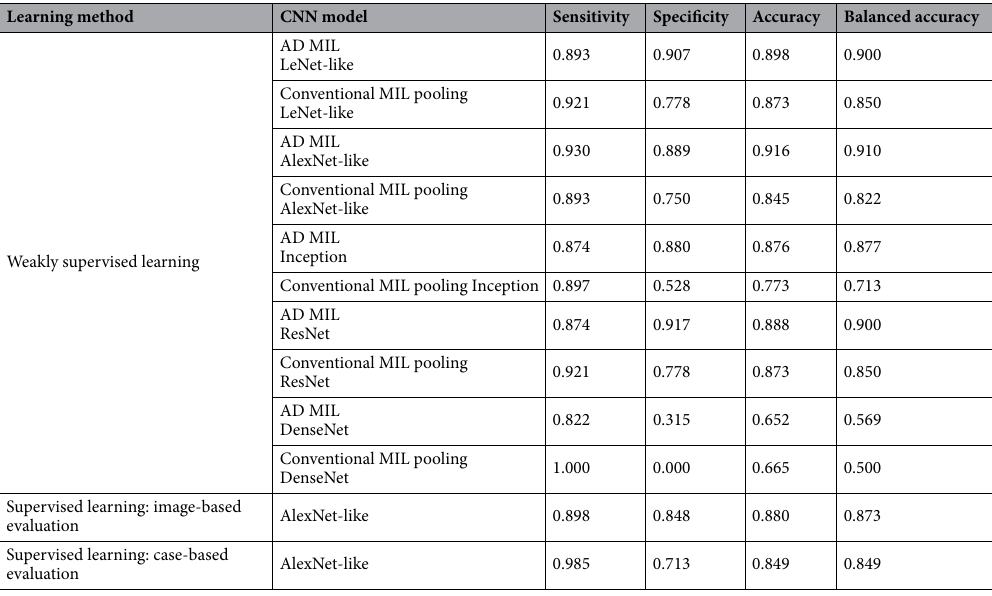
Table 8. Classification